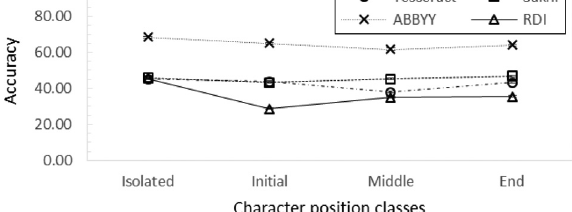
Figure 3. Overall accuracy versus resolution results from the OCR system